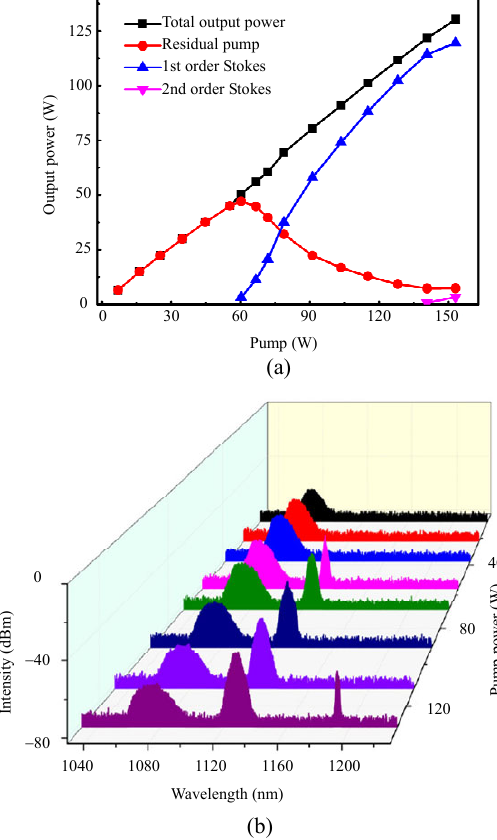
Fig. 2 Output properties: (a) the output power evolution of the Raman fiber laser and (b) the spectra evolution of the Raman fiber laser.